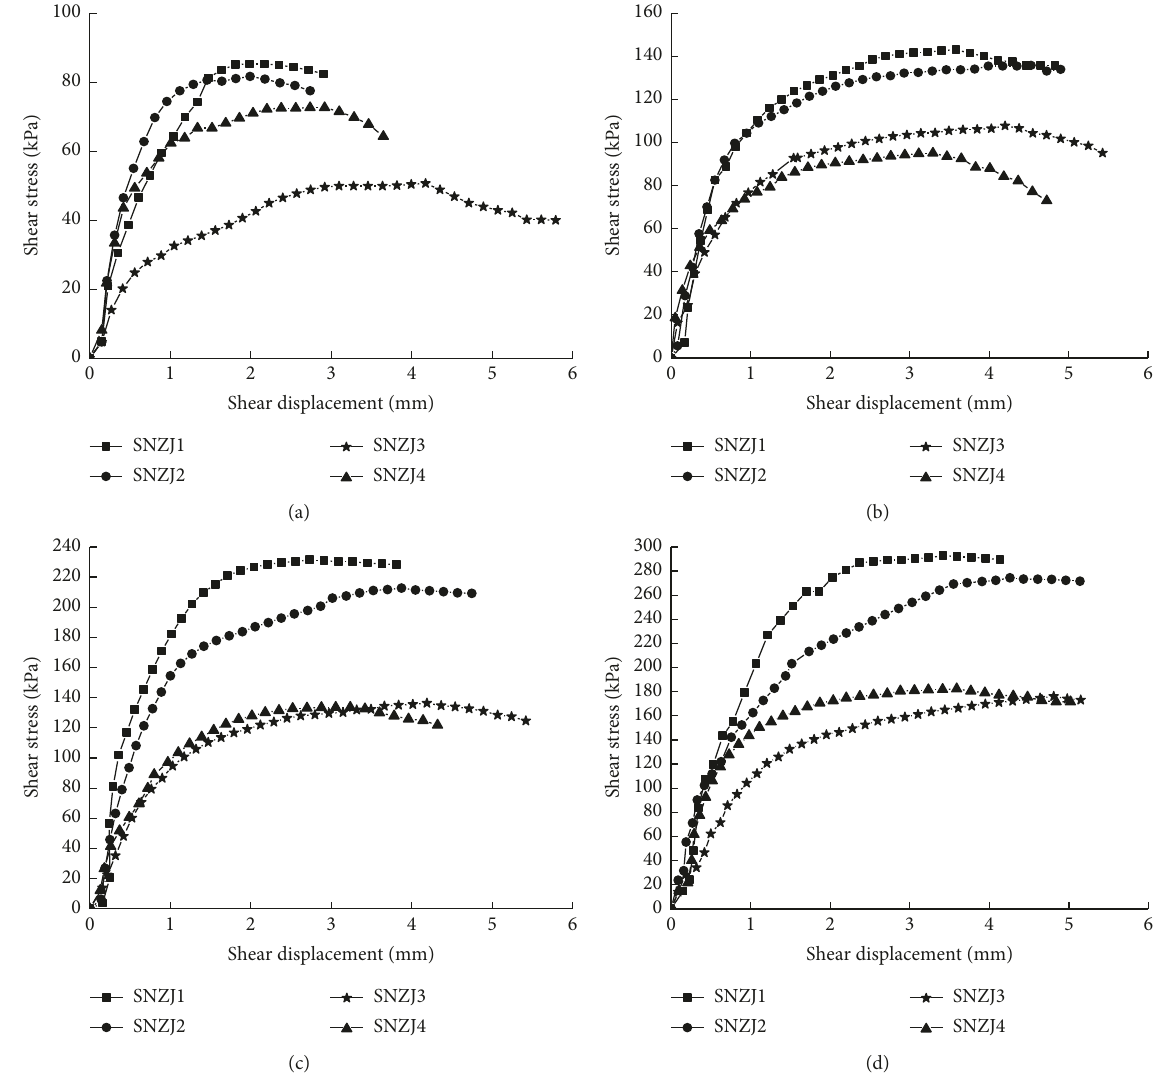
Figure 9: Shear stress-shear displacement curves of laboratory direct shear tests: (a) 100 kPa; (b) 200kPa; (c) 300kPa; (d)